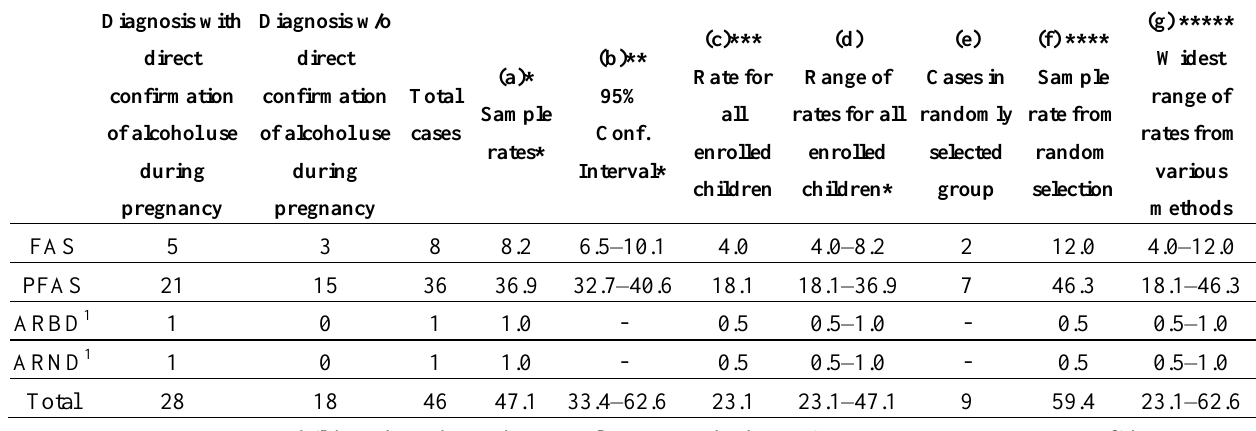
Table 4. Cases diagnosed and estimated rates of FASD among first grade school children in the Lazio Region,